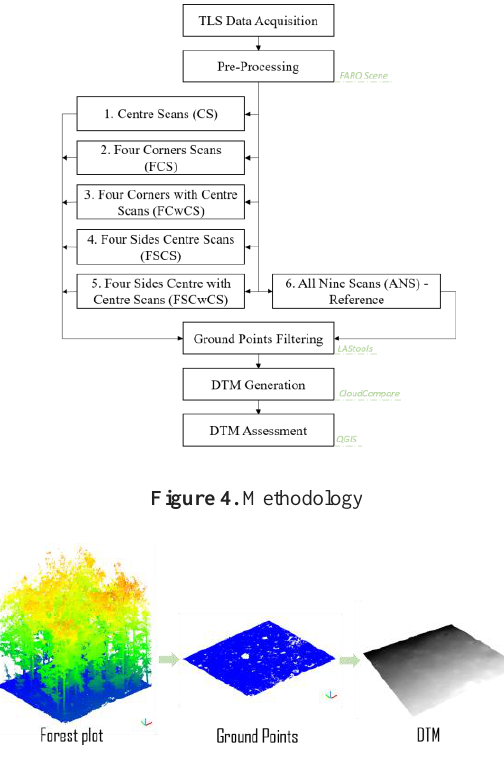
Figure 5. Illustration of forest plot 1 with filtered ground points and DTM